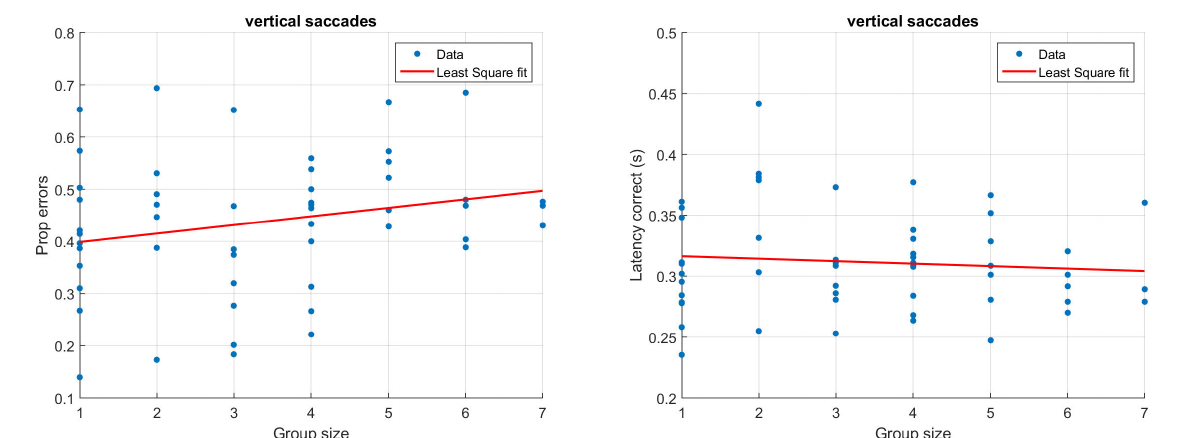
Figure 4 . Proportion of antisaccade errors (left) and latency of correct antisaccades (right) for vertical saccades. Each dot represents average results from one